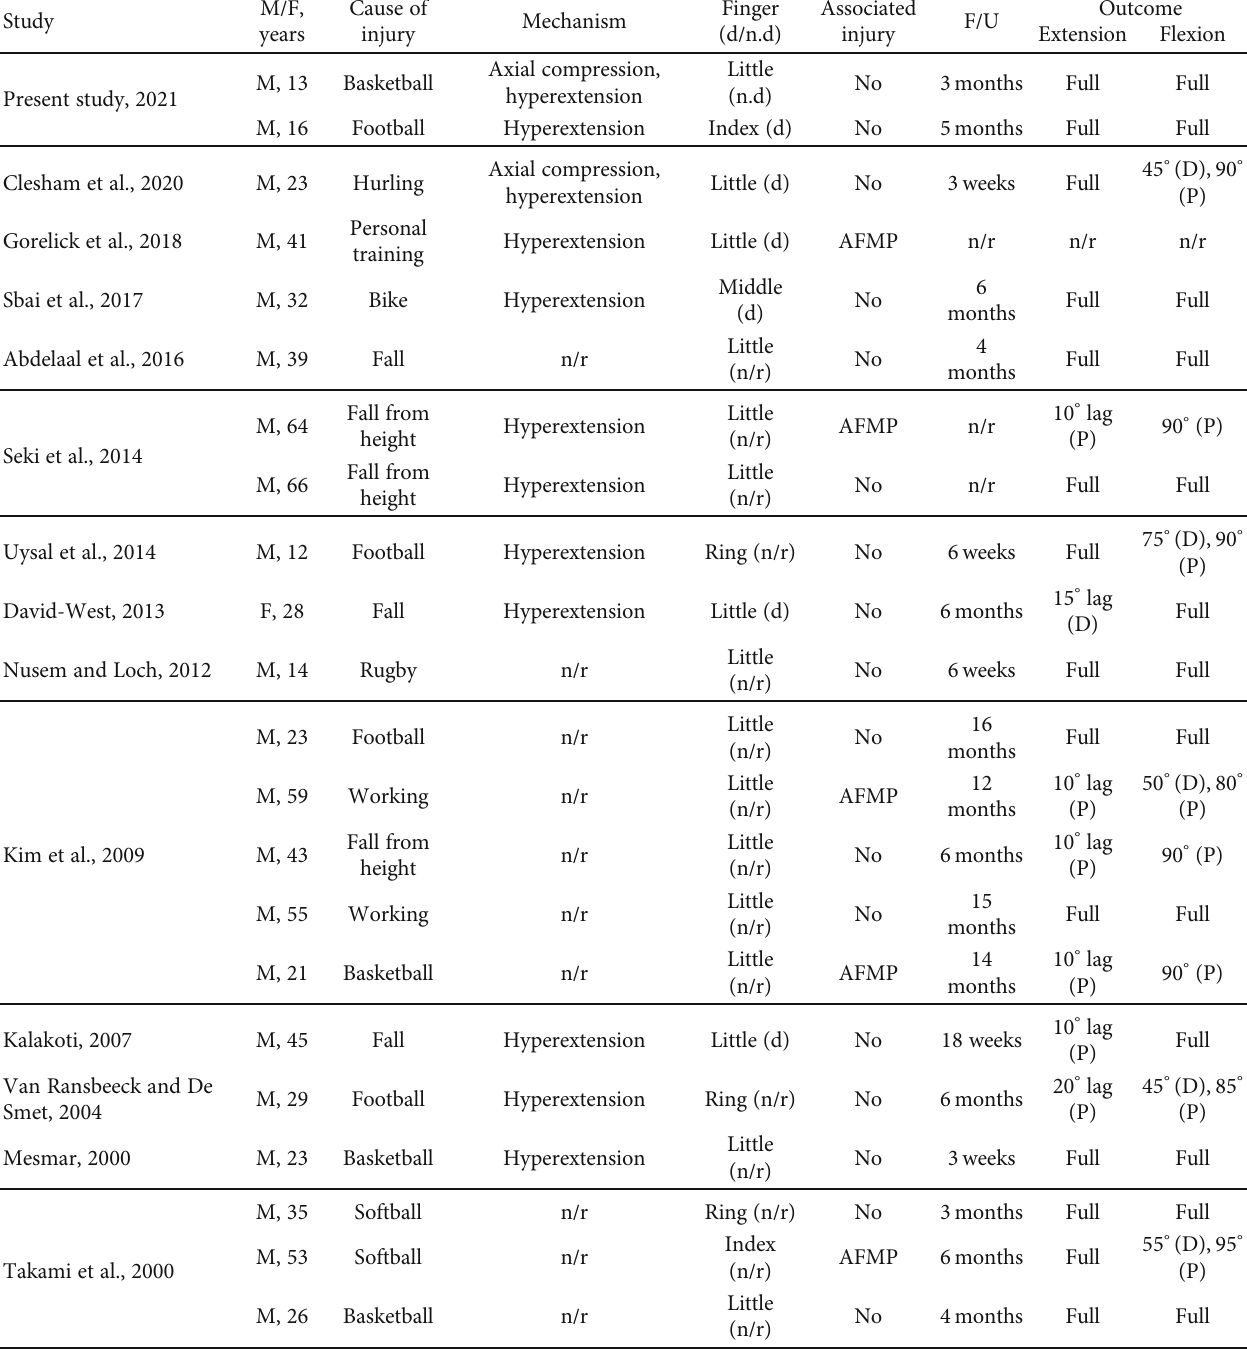
Table 1: List of publications of dorsal dislocation of the proximal and distal interphalangeal joints of the same fi nger.